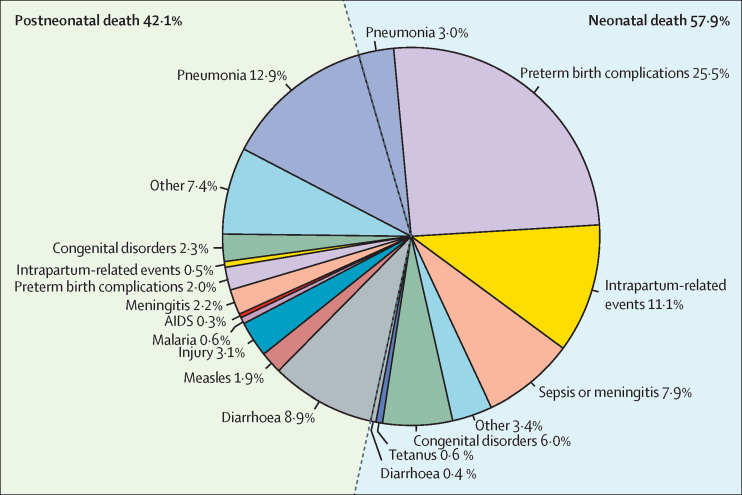
Distribution of causes of under-5 deaths in 2015Causes are separated by age group (<1 month and 1–59 months).